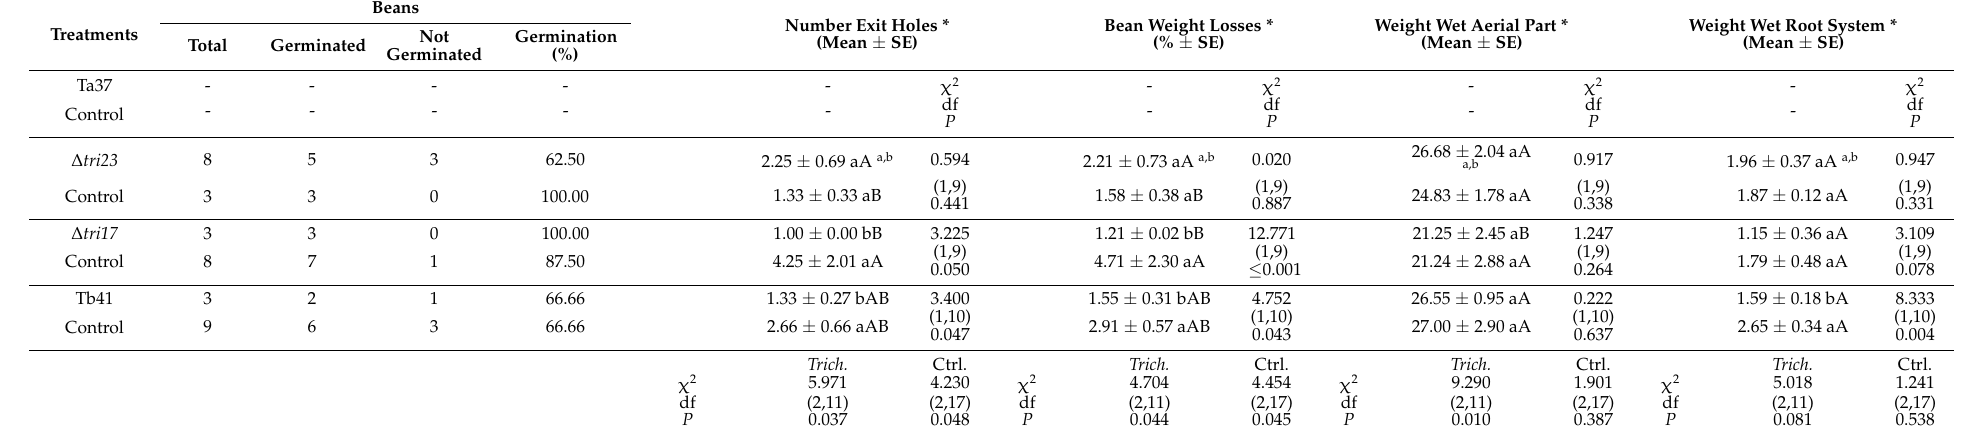
Table 1. Germination capacity of damaged beans sprayed with different Trichoderma strains and agronomic traits of P. vulgaris plants after 45 days (and their controls).